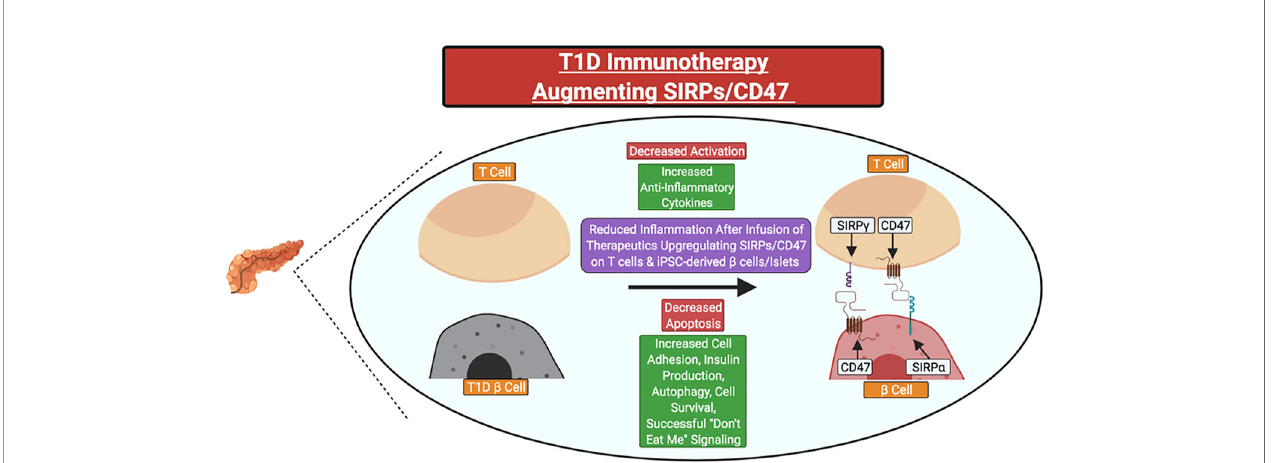
FIGURE 4 | Potential clinical therapeutics targeting SIRPs and CD47 for type 1 diabetes prevention or suspension. Immunotherapies could be utilized to increase the expression of SIRP g and/or CD47 on primary T cells for adoptive cell therapies or CD47 on stem cell-derived b -cells or islets before transplant to attenuate the magnitude of recurrent autoimmunity. Red Text Box: Expected Decrease; Green Text Box: Expected